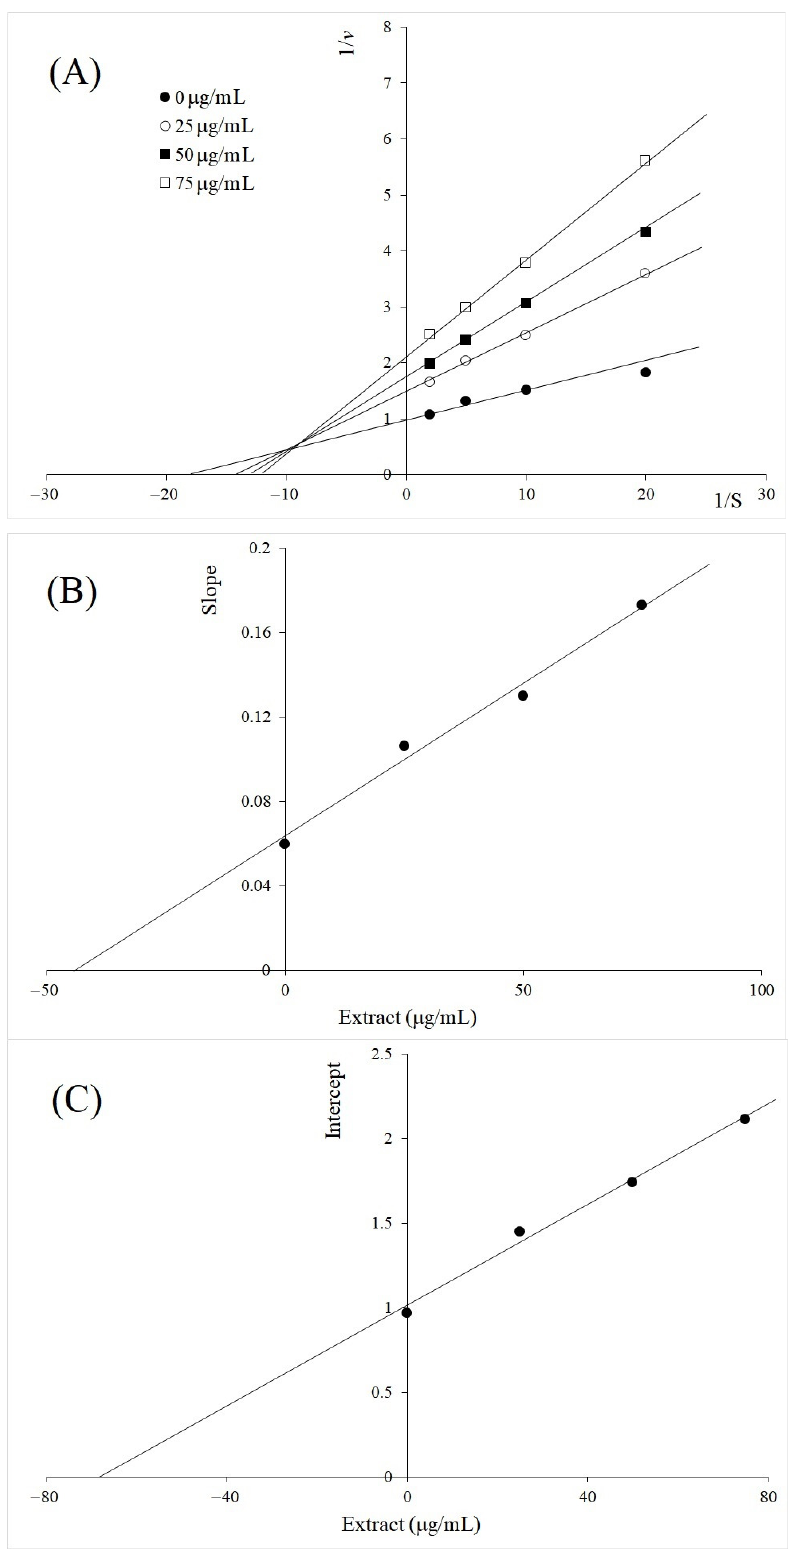
Figure 4. Inhibition kinetics of V. vinifera on TYR diphenolase activity at different concentrations (25, 50, and 100 µg/mL). ( A ) Lineweaver–Burk plot; ( B ) secondary plot between inhibitor concentration and the slope (linear equation; y = 0.001452x + 0.06289, R 2 = 0.9868); ( C ) secondary plot between inhibitor concentrations and intercept (linear equation; y = 0.01492x + 1.011, R 2 = 0.9903).